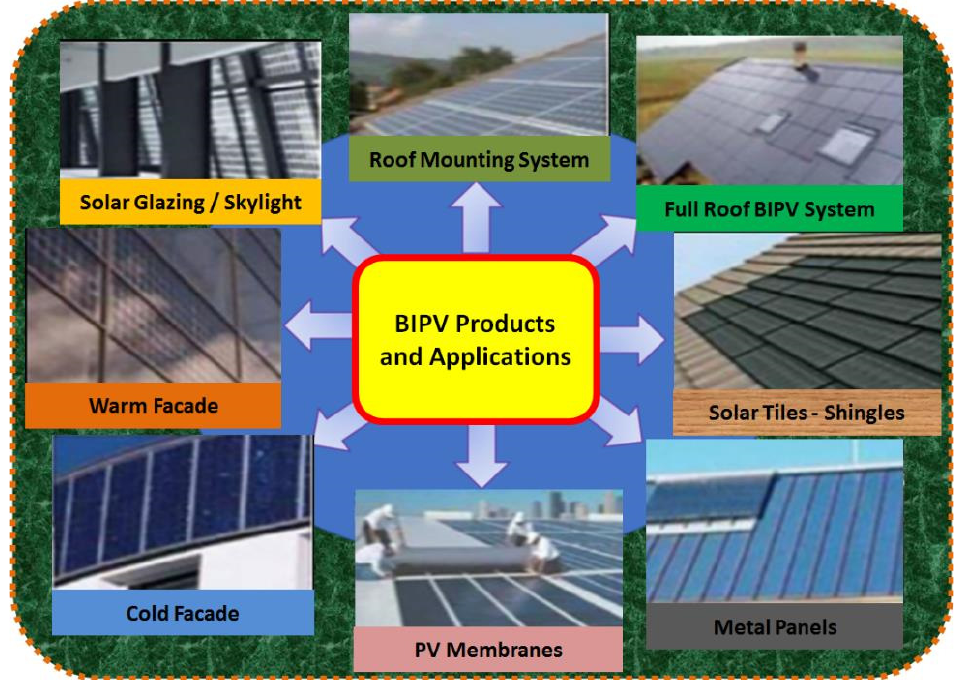
Figure 2. Example of BIPV products and their applications towards facing the green global challenges and achieving a sustainable green globe.